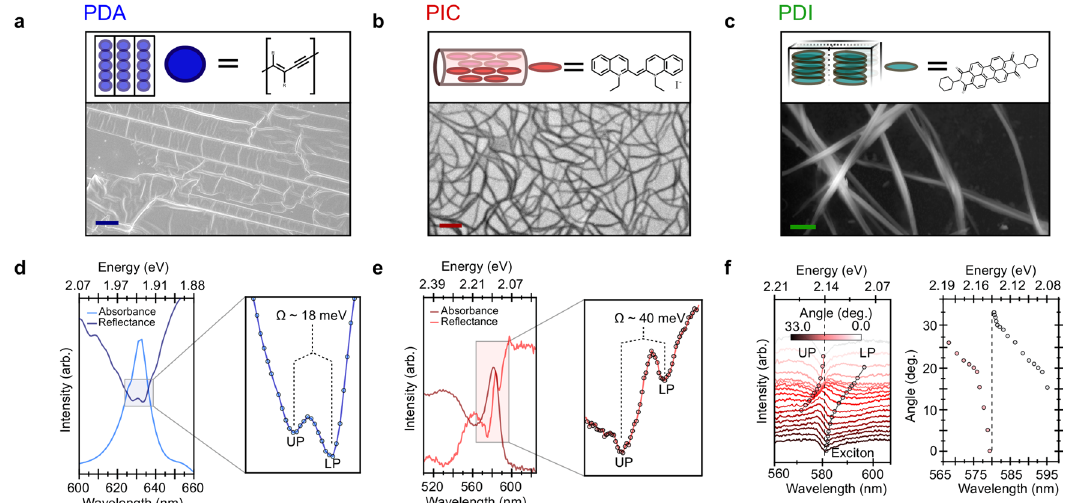
Fig. 1 Structural characterisation of quasi-one dimensional organic semiconductors studied and experimental evidence for light-matter coupling. a Cartoon and scanning electron-microscopy (SEM) image of PDA. The polymer chains consist of a single-double-single-triple bonded back bone and are near perfectly aligned in 100 μ m 2 domains. Scale bar is 10 μ m. b Molecular packing and transmission electron-microscopy image of PIC nanotubes. The cyanine based monomers pack in a brickwork pattern to form nanotubes. They are embedded in a rigid sucrose-trehalose matrix and tend to be highly bundled in fi lms; scale bar 100 nm. c PDI molecules pi-face stack in a quasi-H-aggregate fashion and in four distinct blocks (black outlines) to form ~100 μ m long, 50 nm wide nanobelts; scale bar 250 nm. d Absorption (light blue) and specular re fl ection (dark blue) spectra of PDA. Zooming into the zero-phonon peak at 1.965 eV (right) shows it is split by ~18 meV ( Ω ) into two branches, an upper (UP) and lower polariton (LP). e Absorption (maroon) and specular re fl ection (red) spectra of PIC. The excitonic peak at 2.132 eV is split by ~40 meV due to the formation of exciton-polaritons (right). f Angle resolved re fl ectivity for PIC. Solid red and black lines highlight angle-dependent dips below and above the excitonic transition (dashed line), respectively. The energy of the dips as a function of angle (adjacent) reveals the typical anti-crossing behaviour of strong coupling between a cavity photon-mode and an excitonic transition (dashed